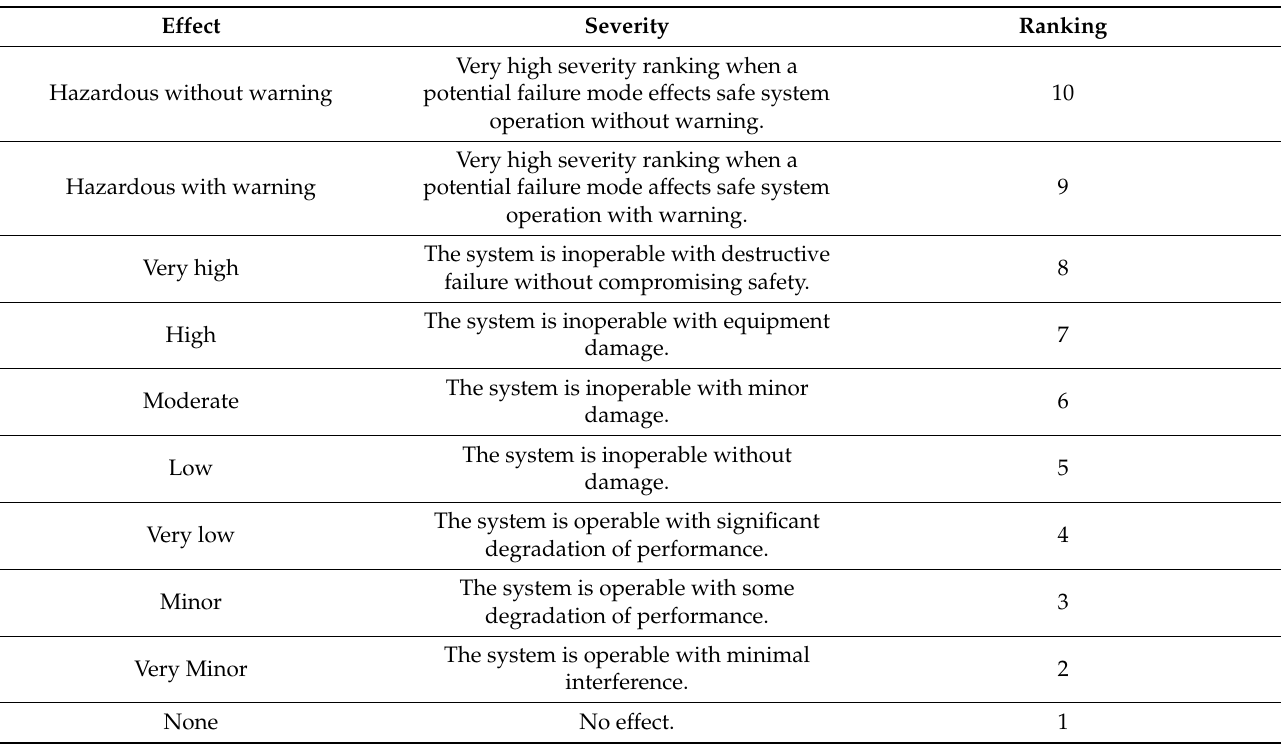
Table A3. Severity criteria.